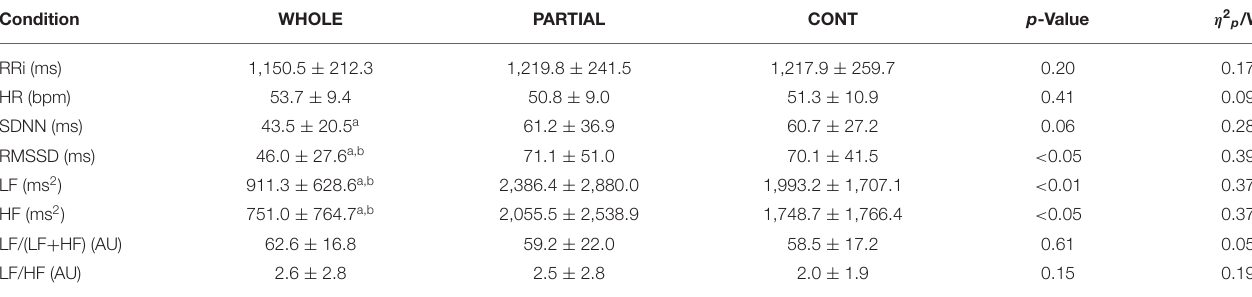
TABLE 3 | Heart rate variability analysis during the first SWS sequence in WHOLE ( n = 12), PARTIAL ( n = 12), and CONT ( n = 10) conditions.